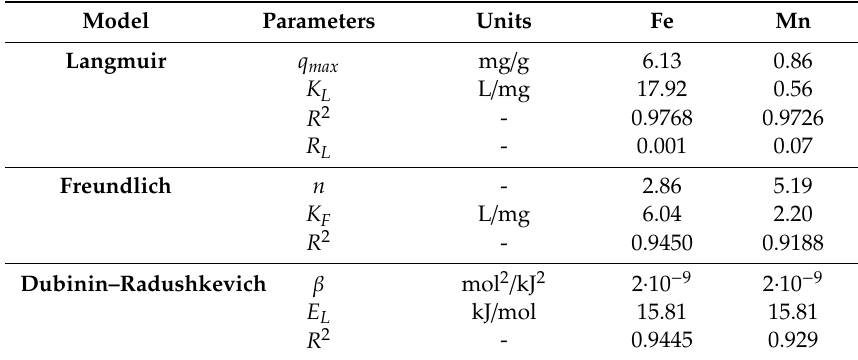
Table 4. Langmuir, Freundlich, and Dubinin–Radushkevich isotherm parameters for Fe and Mn removal using NZ 200 at di ff erent adsorbent